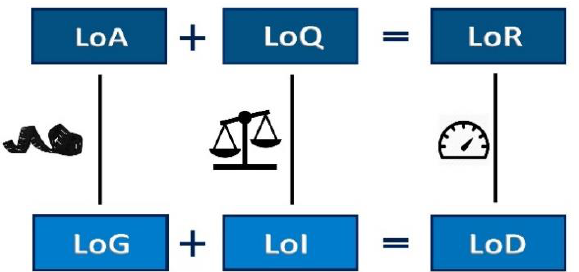
Figure 1: The model’s reliability is the synergy of the geometric accuracy (LoA) and the quality of information sources